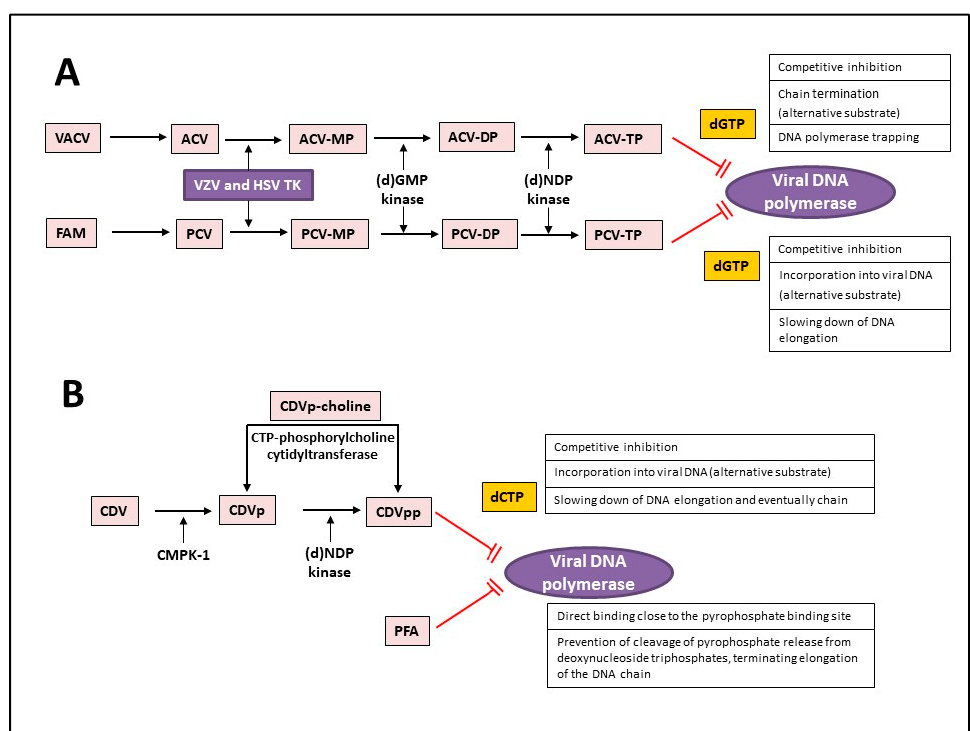
Figure 1. Activation and mechanism of action of ( A ) acyclovir (ACV) and penciclovir (PCV) and ( B ) cidofovir (CDV) and foscarnet (PFA). Valacyclovir (VACV), the oral prodrug of ACV, has improved absorption compared to ACV because of